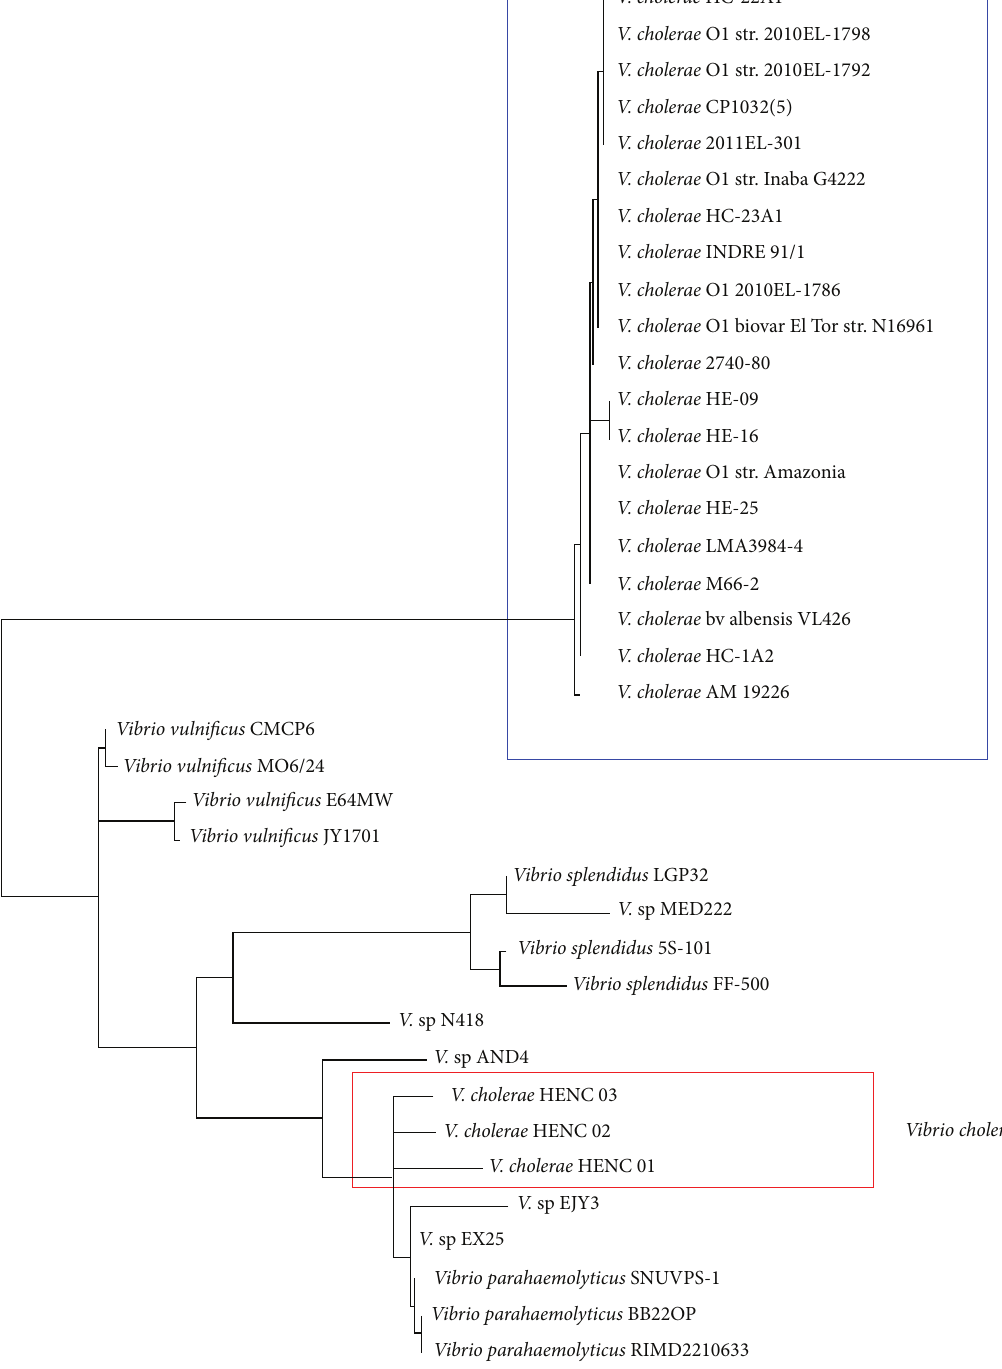
Figure 4: A 16S-based phylogenetic tree. V. cholera HENC 01, V. cholera HENC 02, and V. cholera HENC 03 are clustered into a group (red box), rather than with other V. cholera strains (blue box). The three strains are closely related to V. parahaemolyticus species. These results suggest that the three strains might be inappropriately classified into V. cholera